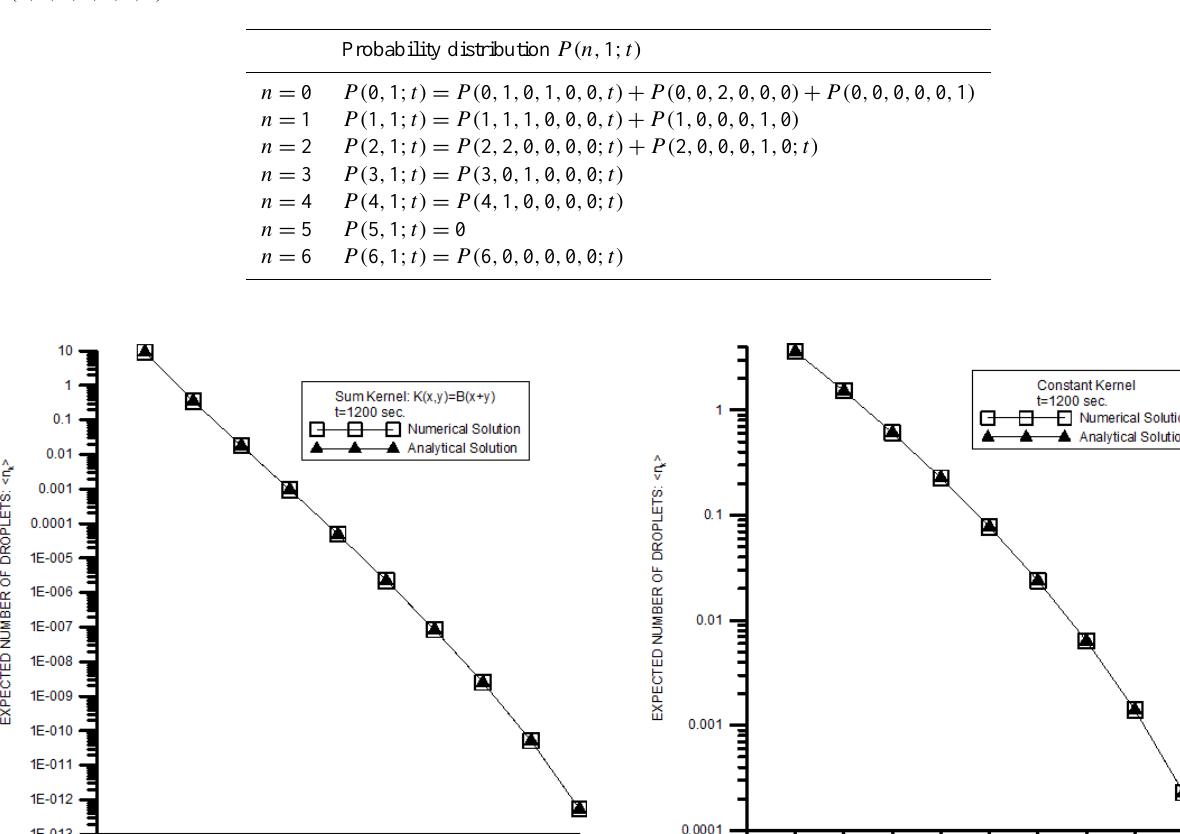
Table 1. Probability distribution P(n, 1 ; t) of finding n particles of size m = 1 at time t , for a system with the initial condition P( 6 , 0 , 0 , 0 , 0 , 0 ; 0 ) = 1.